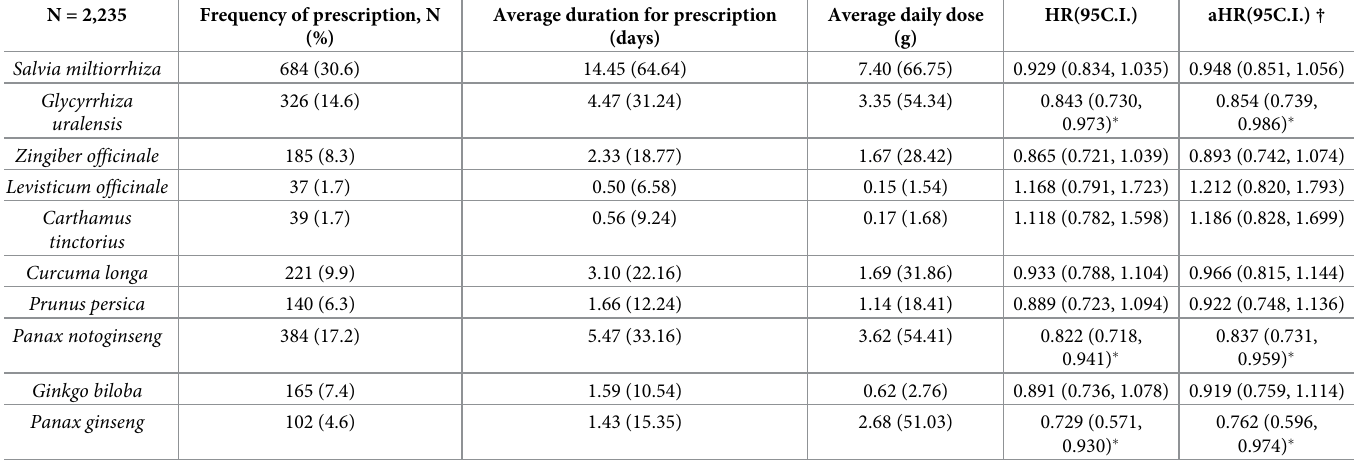
Table 3. Statistics of CHMs previously reported for possible herb-drug interactions with anticoagulants with frequency of prescription, average duration for pre- scription, average daily dose and hazard ratio hazard ratio of major bleeding events between CHM and non-CHM cohort. N =